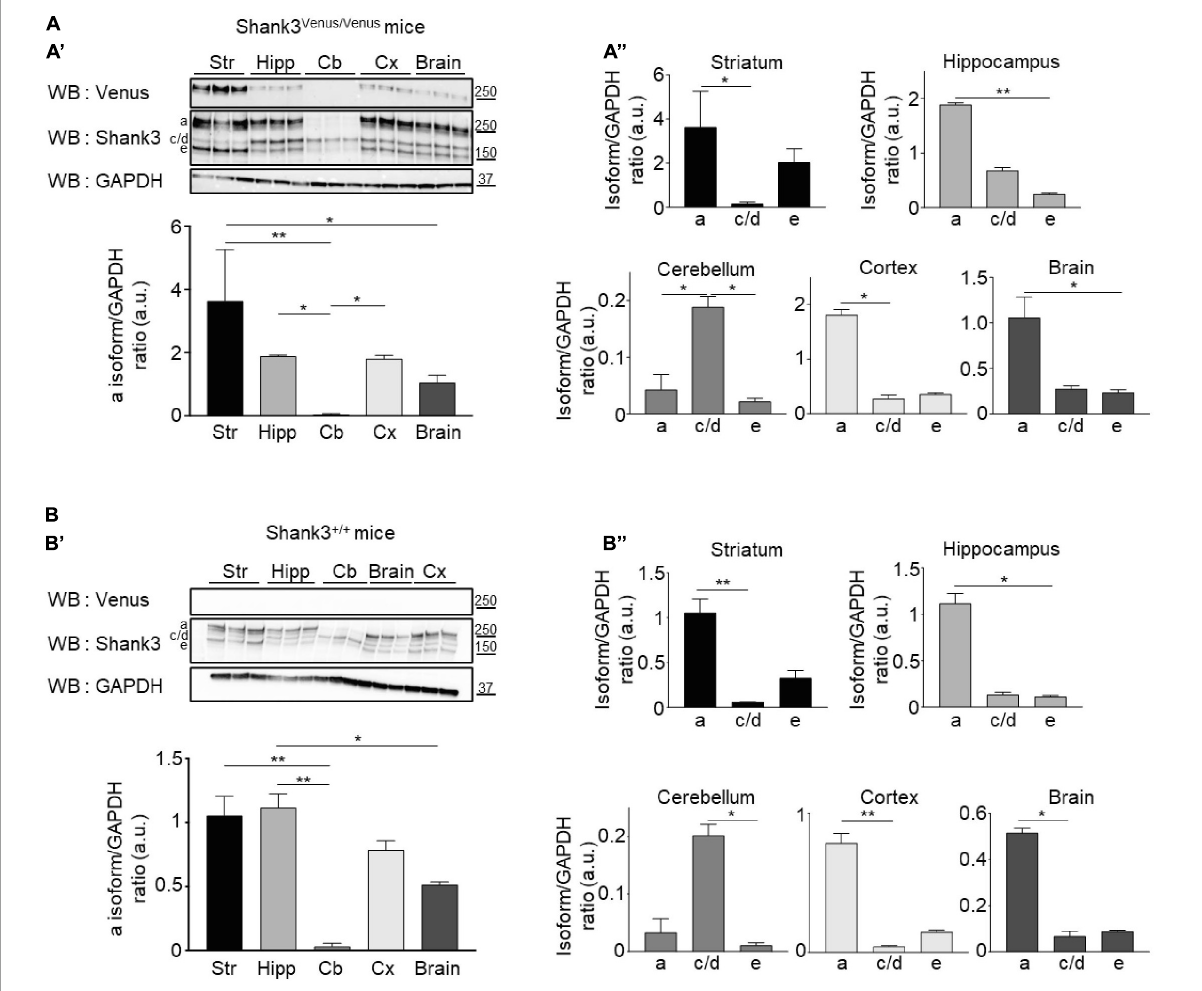
FIGURE4 Shank3 protein isoforms expression in different brain areas. ( A , Top A’ ) Total lysates of striatum (Str), hippocampus (Hipp), cerebellum (Cb), cortex (Cx), and full brain from 3 different Shank3 Venus / Venus adult mice immunoblotted for Venus, Shank3 and GAPDH. (Bottom A’ ) Summary graph of the Shank3a/GAPDH ratios (quantified using Shank3 antibody). ( A” ) Graphs present the Shank3a, Shank3c/d and Shank3e over GAPDH ratios in the full brain or the different brain areas (quantified with Shank3 antibody). (B) Same as panel (A) but in 3 Shank3 + / + adult mice. For panels (A,B) data are mean ± SEM, *indicates p -value < 0.05, ** p < 0.01, non-parametric Kruskal–Wallis test with uncorrected Dunn’s